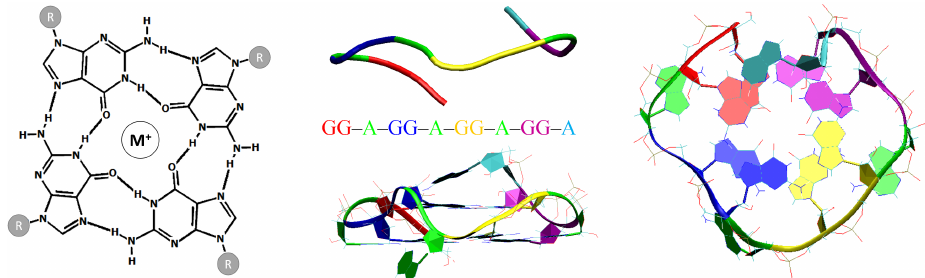
Figure 1. Left panel: Schematic representation of a G-tetrad with a coordinated metal cation. Central and right panels: The PDB ID 2RQJ structure that was used as a reference for the investigated series of intramolecular RNA two-tetrad G-quadruplex systems. Loops and caps are coloured green and cyan,